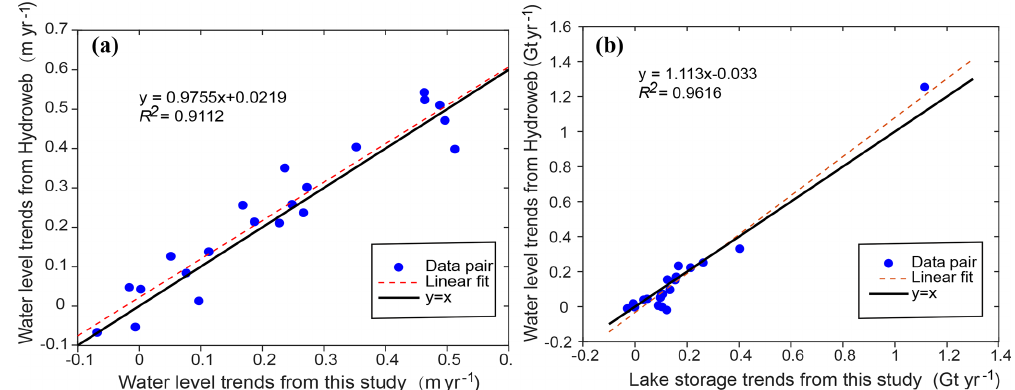
Figure 11. Cross validation of the TP lake level and storage changes derived from our study with those provided by the LEGOS Hydroweb database (Crétaux et al., 2011a): (a) trends in lake water levels from 2003 to 2015 and (b) trends in lake water storage from 2003 to 2015.